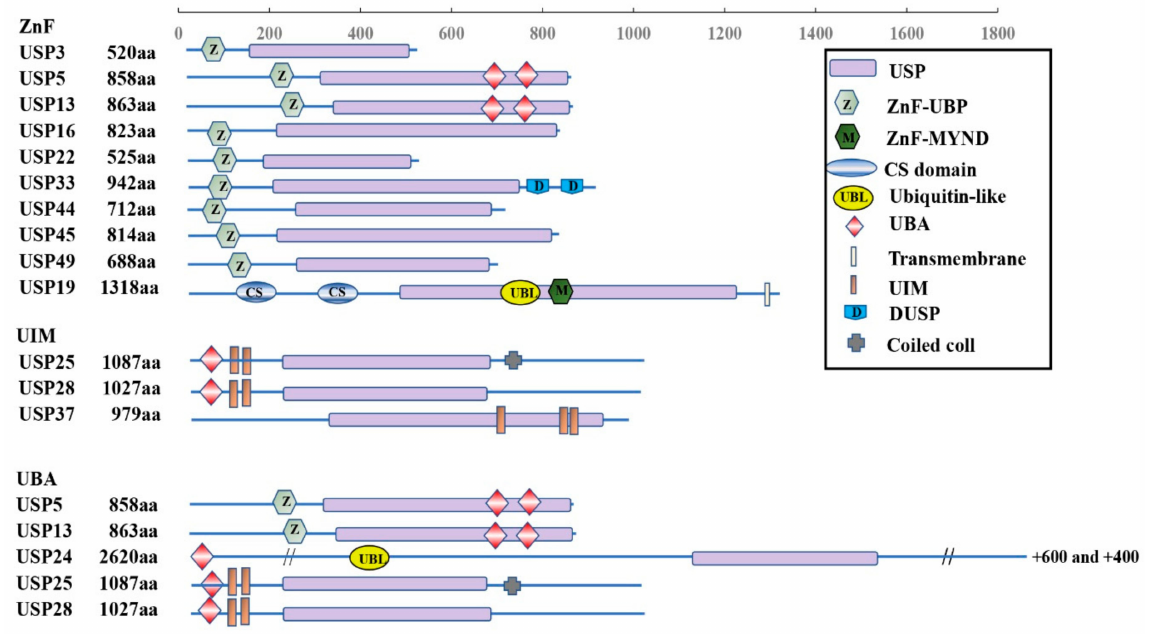
Figure 1. Schematic illustration of ZnF, UIM, and UBA subfamily architectures.